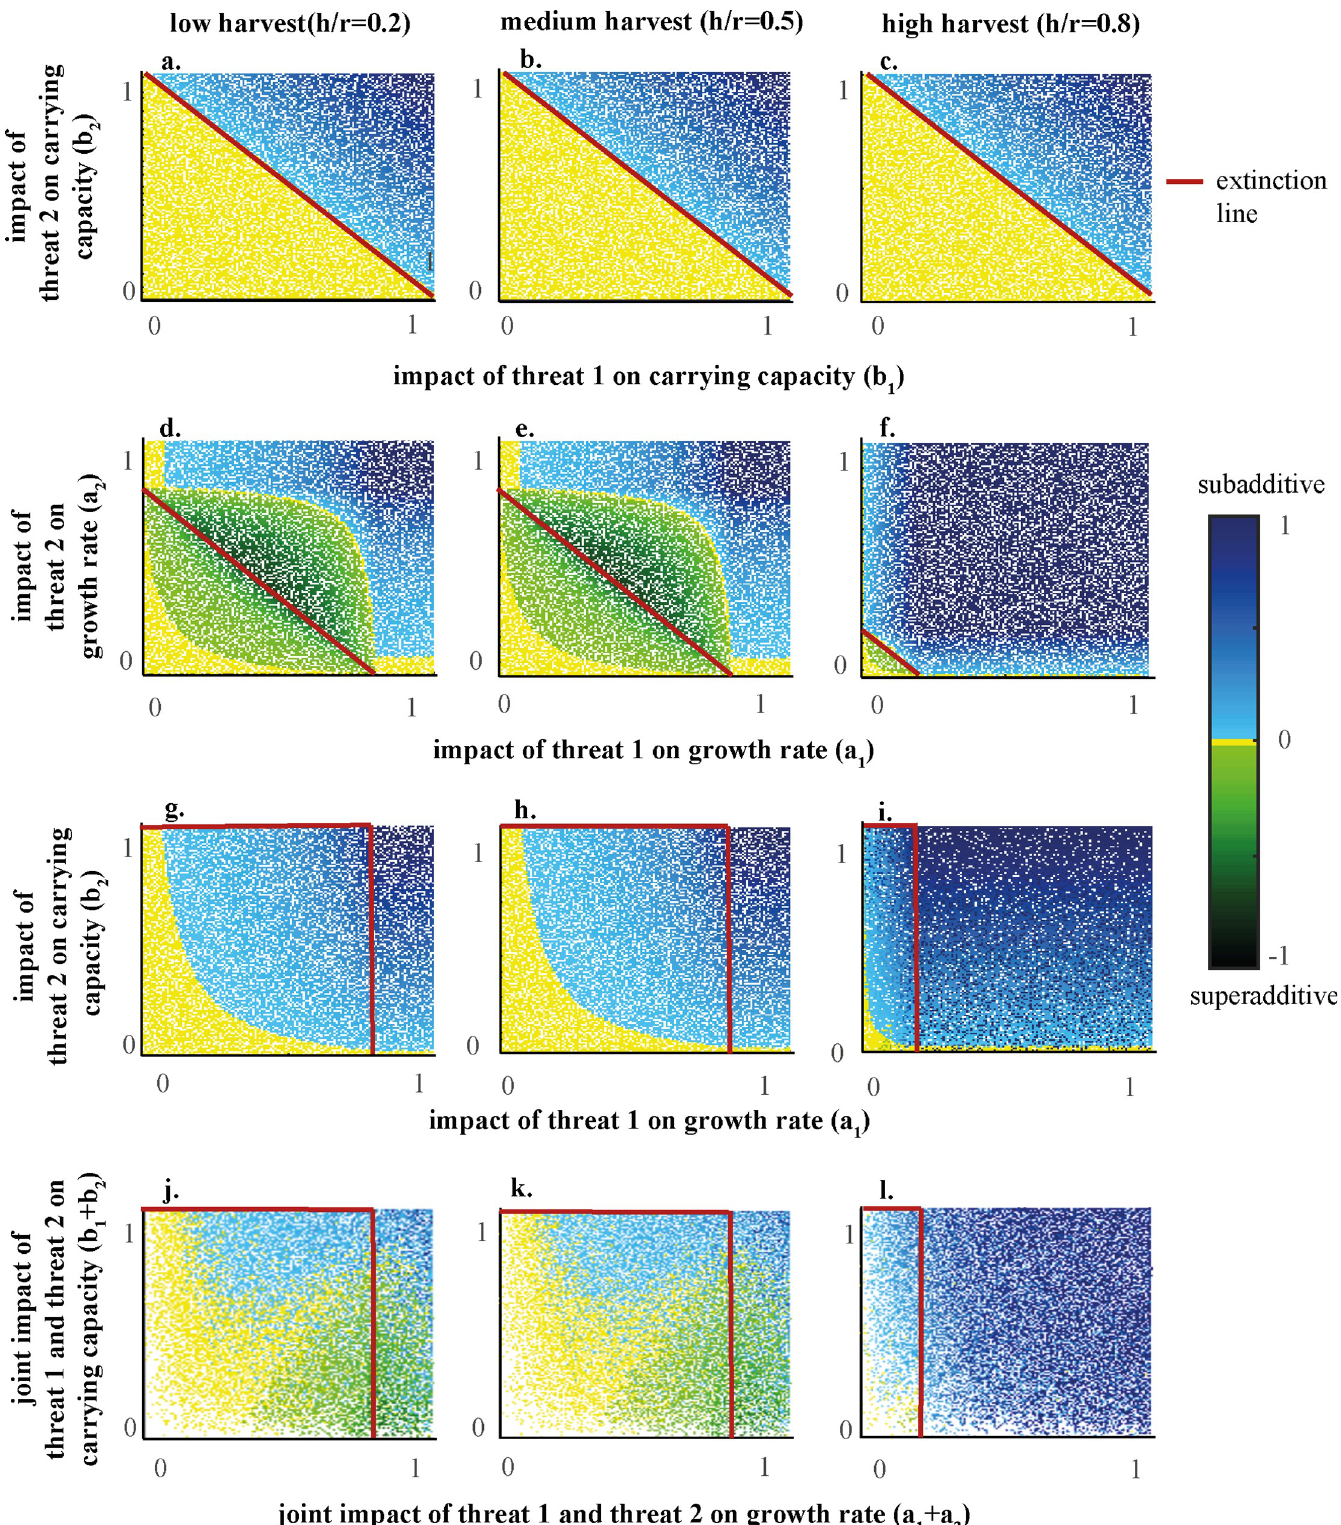
Fig 2. Additivity indices for 106 simulations of random values for h and r split into three cases depending on the parameter impacted by the threats. The four cases represent: a-c: Case 1; Two threats that only impact the carrying capacity ( a 1 = a 2 = 0, b 1 , b 2 6¼ 0); d-f: Case 2; Two threats that only impact the growth rate ( a 1 , a 2 6¼ 0,